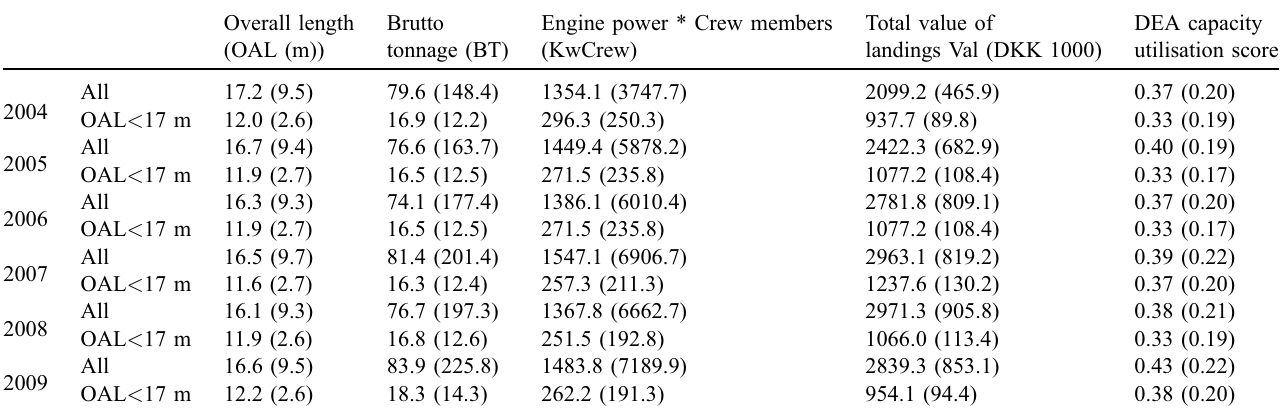
Table 4. Vessel averages and standard deviations (in parentheses) of the input (OAL, BT, KwCrew) and output (Val, DKK 1000) variables to the DEA analyses and of the resulting DEA capacity utilisation